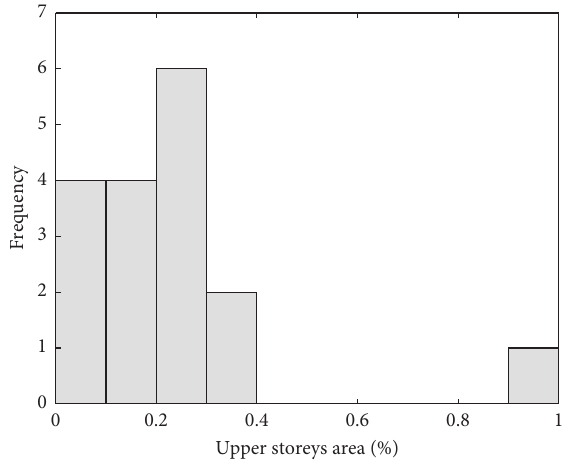
Figure 11: Ratio of upper storeys area with respect to the ground